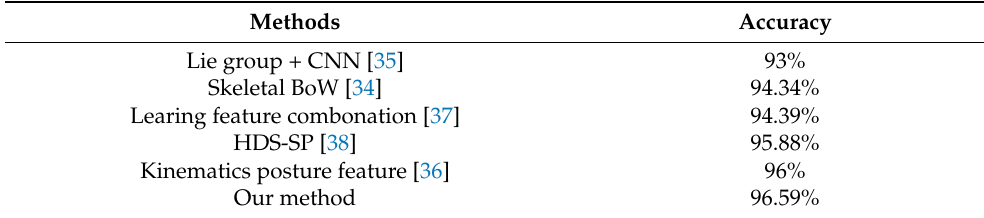
Table 5. Compared with the state-of-the-art methods on Florence-3D